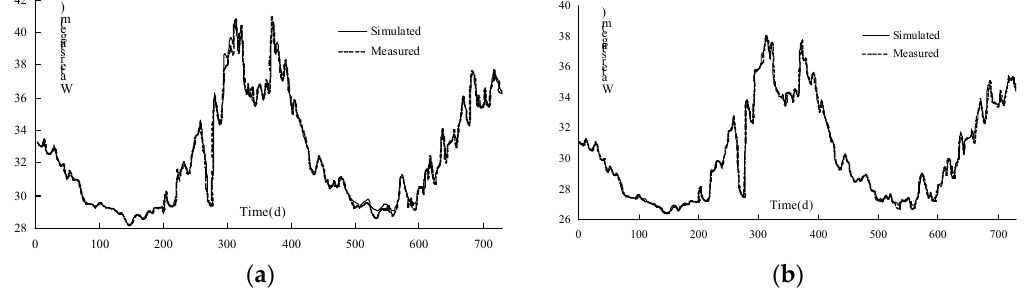
Figure 3. Comparison of the water stages at two control stations. ( a ) Shashi station; ( b ) Xinchang station.